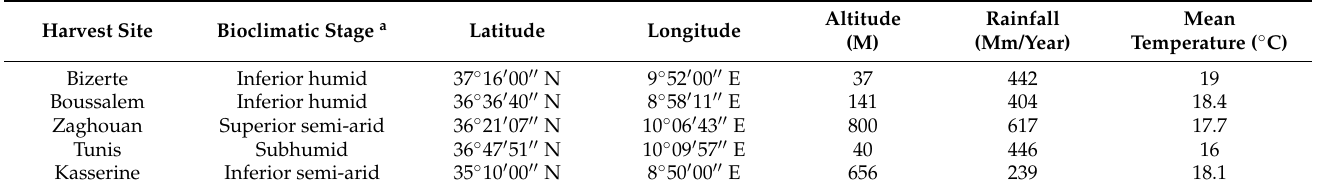
Table 1. Climatic characteristics of the studied localities where M. vulgare was harvested. Harvest